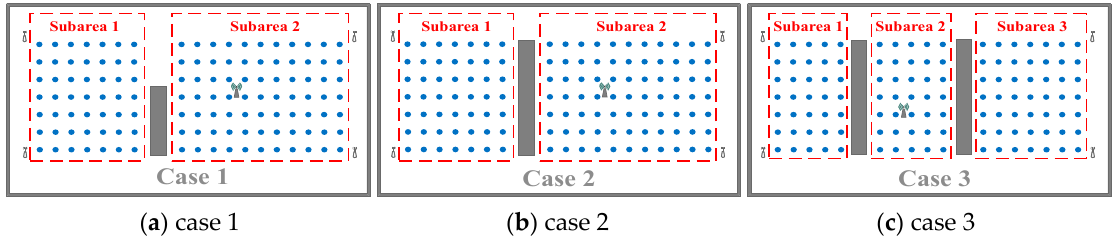
Figure 10. The testbed in NLOS condition.